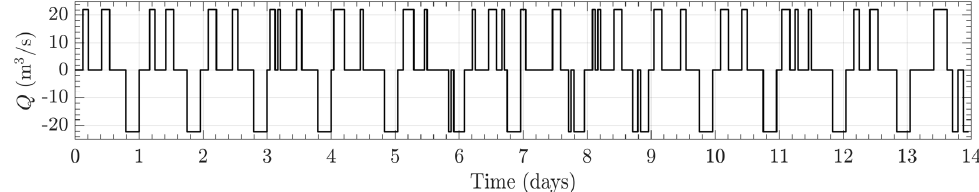
Figure 3. Discharge, Q , pattern for the winter period based on current electricity prices variation in Belgium. Positive and negative discharges correspond to turbining and pumping, respectively.